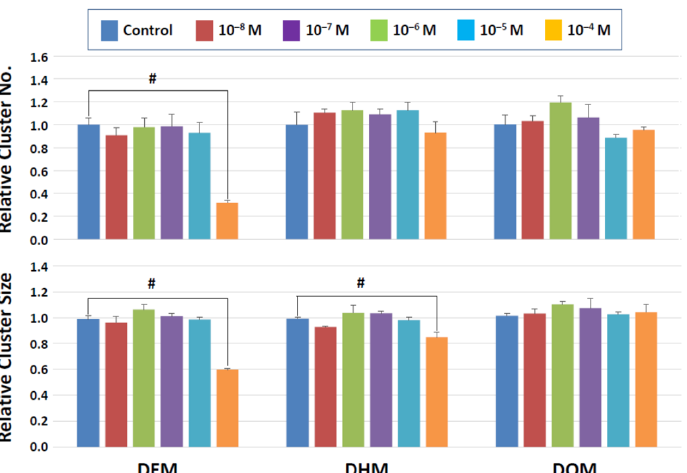
Figure 5. Cluster numbers and sizes after a 2-day exposure to maleate derivatives. The data are normalized to the results of control (DMSO) treatment. Hash signs (#) denote significant differences ( p < 0.05). A significant reduction in cluster numbers is seen with DEM between control and 10 − 4 M whereas cluster sizes decline in the presence of 10 − 4 M DEM and DEH.